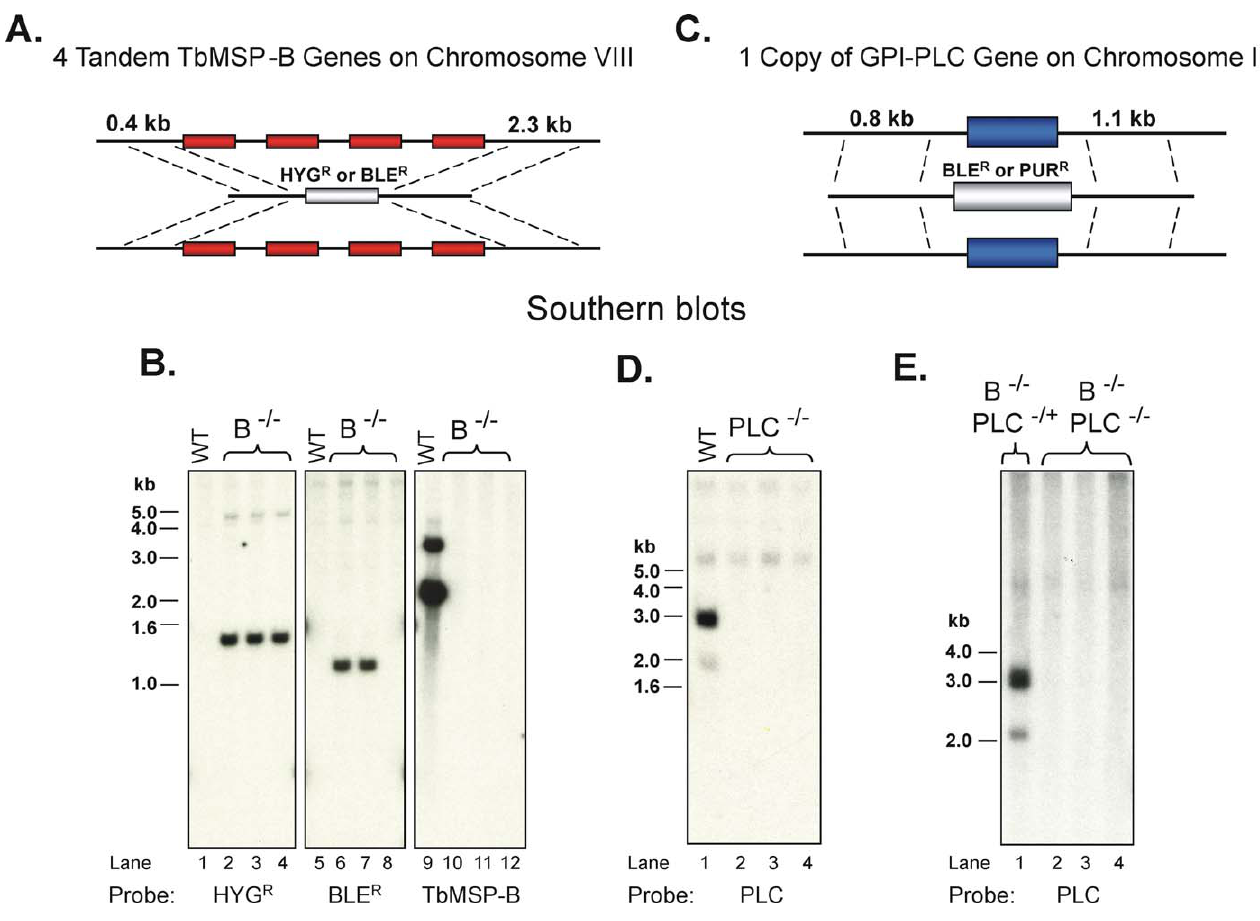
Figure 4. Generation of T. brucei BSF Cell Lines Bearing Gene Deletions (A) The strategy for deleting the cluster of four tandem TbMSP-B genes from both alleles of chromosome VIII utilized 0.4 kb of sequence upstream of the cluster and 2.3 kb of sequence downstream. The cassette used for the deletions contained either the HYG R or BLE R gene for selection with the appropriate antibiotic. (B) Analysis of three cloned MSP-B (cid:2) / (cid:2) cell lines (B (cid:2) / (cid:2) ). The HYG R cassette was transfected first into the WT BSF cell line, followed by transfection with the BLE R cassette. Southern blots of genomic DNAs from WT and three cloned B (cid:2) / (cid:2) cell lines cleaved with XhoI and StuI were probed with the coding regions of HYG R (lanes 1–4) or BLE R (lanes 5–8), and the same genomic DNAs cleaved with HindIII were probed with the coding sequence of TbMSP-B (lanes 9–12). Lanes 4, 8, and 12 show a cell line that does not contain the BLE R gene but does lack all copies of the TbMSP-B gene (see text). This B (cid:2) / (cid:2) cell line was used in differentiation experiments and to generate doubly deleted B (cid:2) / (cid:2) PLC (cid:2) / (cid:2) cell lines (see [E]). (C) Strategy for generating PLC (cid:2) / (cid:2) cell lines. Both alleles of the single-copy GPI-PLC gene were replaced with cassettes containing either the BLE R or PUR R gene flanked by a 0.8-kb upstream and 1.1-kb downstream genomic sequence. (D) Southern blot of genomic DNAs from WT BSF cells and three BSF PLC (cid:2) / (cid:2) cell lines cleaved with NdeI and probed with the PLC coding sequence. (E) Southern blots of genomic DNA from a B (cid:2) / (cid:2) cell line transfected with the GPI-PLC deletion cassettes. The B (cid:2) / (cid:2) cell line shown in lane 12 of (B) was transfected first with the PLC/BLE R cassette (lane 1). The resulting B (cid:2) / (cid:2) PLC (cid:2) / þ cell line in lane 1 was then transfected with the PLC/PUR R cassette to generate a doubly deleted cell line, three clones of which are shown in lanes 2–4. The genomic DNAs were cleaved with NdeI and probed with the PLC coding